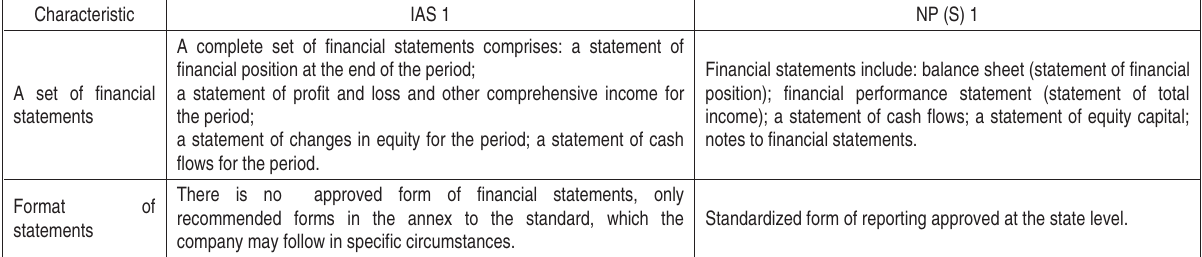
Table 1 (cont.). Regulatory requirements to financial reporting according to IAS 1 and NP (S) 1